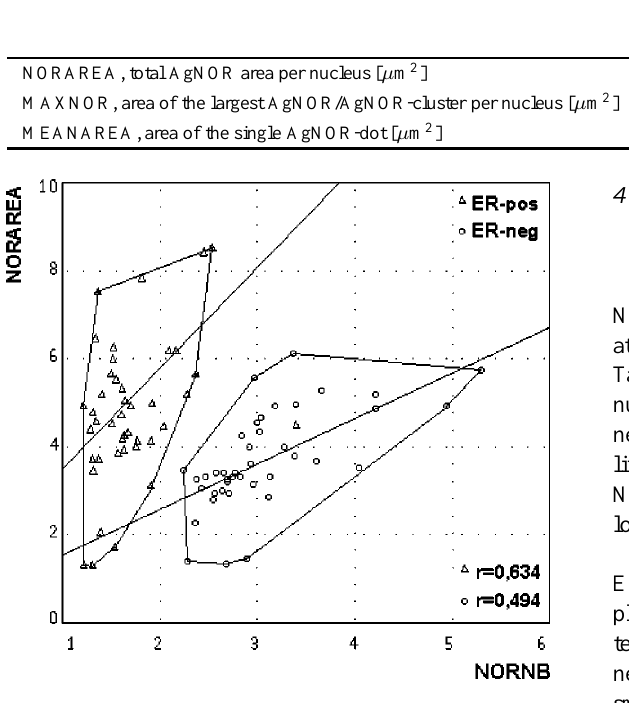
Fig. 3. Correlation between total AgNOR area per nucleus (NORAREA) and AgNOR number per nucleus (NORNB) in ER-positive (ER-pos) and ER-negative (ER-neg)